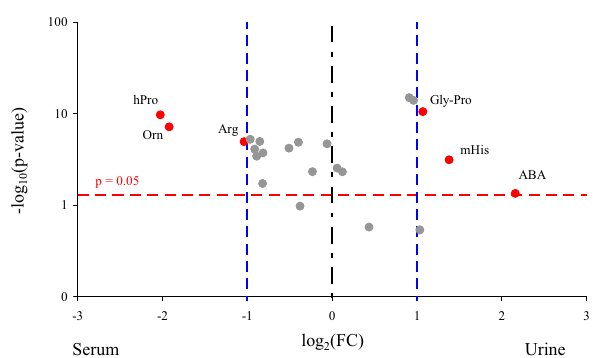
Figure 2. Volcano plot indicating amino acids with the most meaningful changes analyzed in the urine and serum of septic patients on admission based on univariate analysis—y-axis: Mann–Whitney p value, x-axis: fold change (FC). Each dot represents one amino acid. The amino acids with significance p < 0.05 are located above the red horizontal line. The amino acids with more than a twofold change of a concentration are located on right and left from the respective blue right and left vertical lines. Only red dots indicate amino acids with the clinical and statistical differences. Arg, arginine; ABA, α-aminoisobutyric acid; Gly-Pro, glycine-proline; hPro, 4 hydroxyproline; mHis, 3-methyl-histidine; Orn, ornithine; p , significant